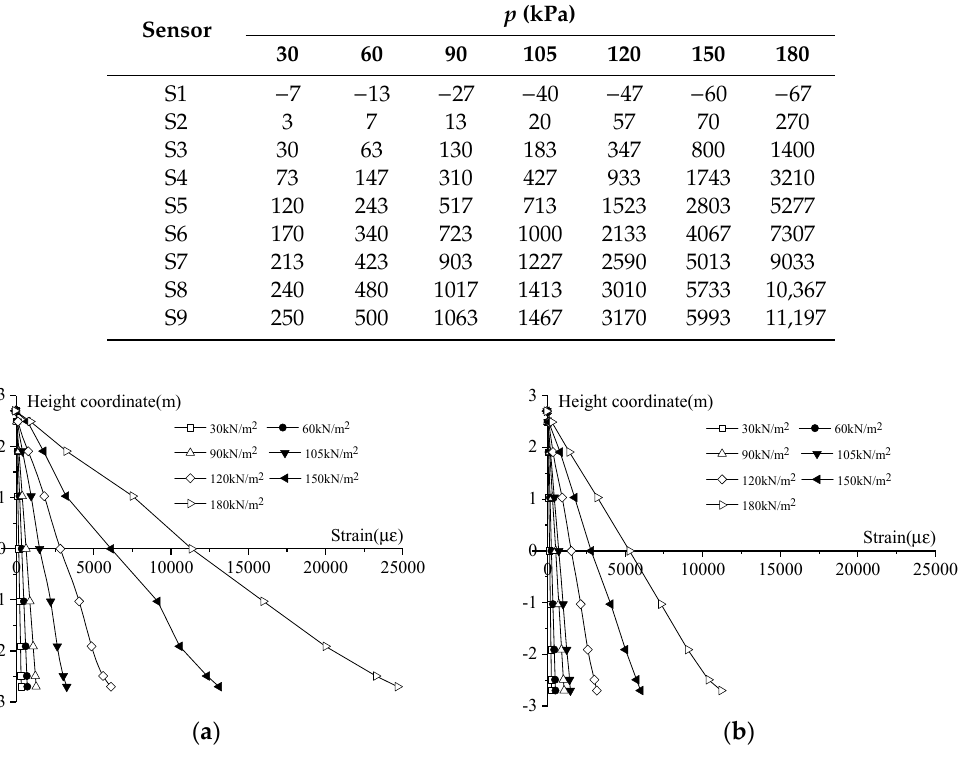
Table 4. The stress of bolts at each loading step in E9 (unit: MPa). Bolt